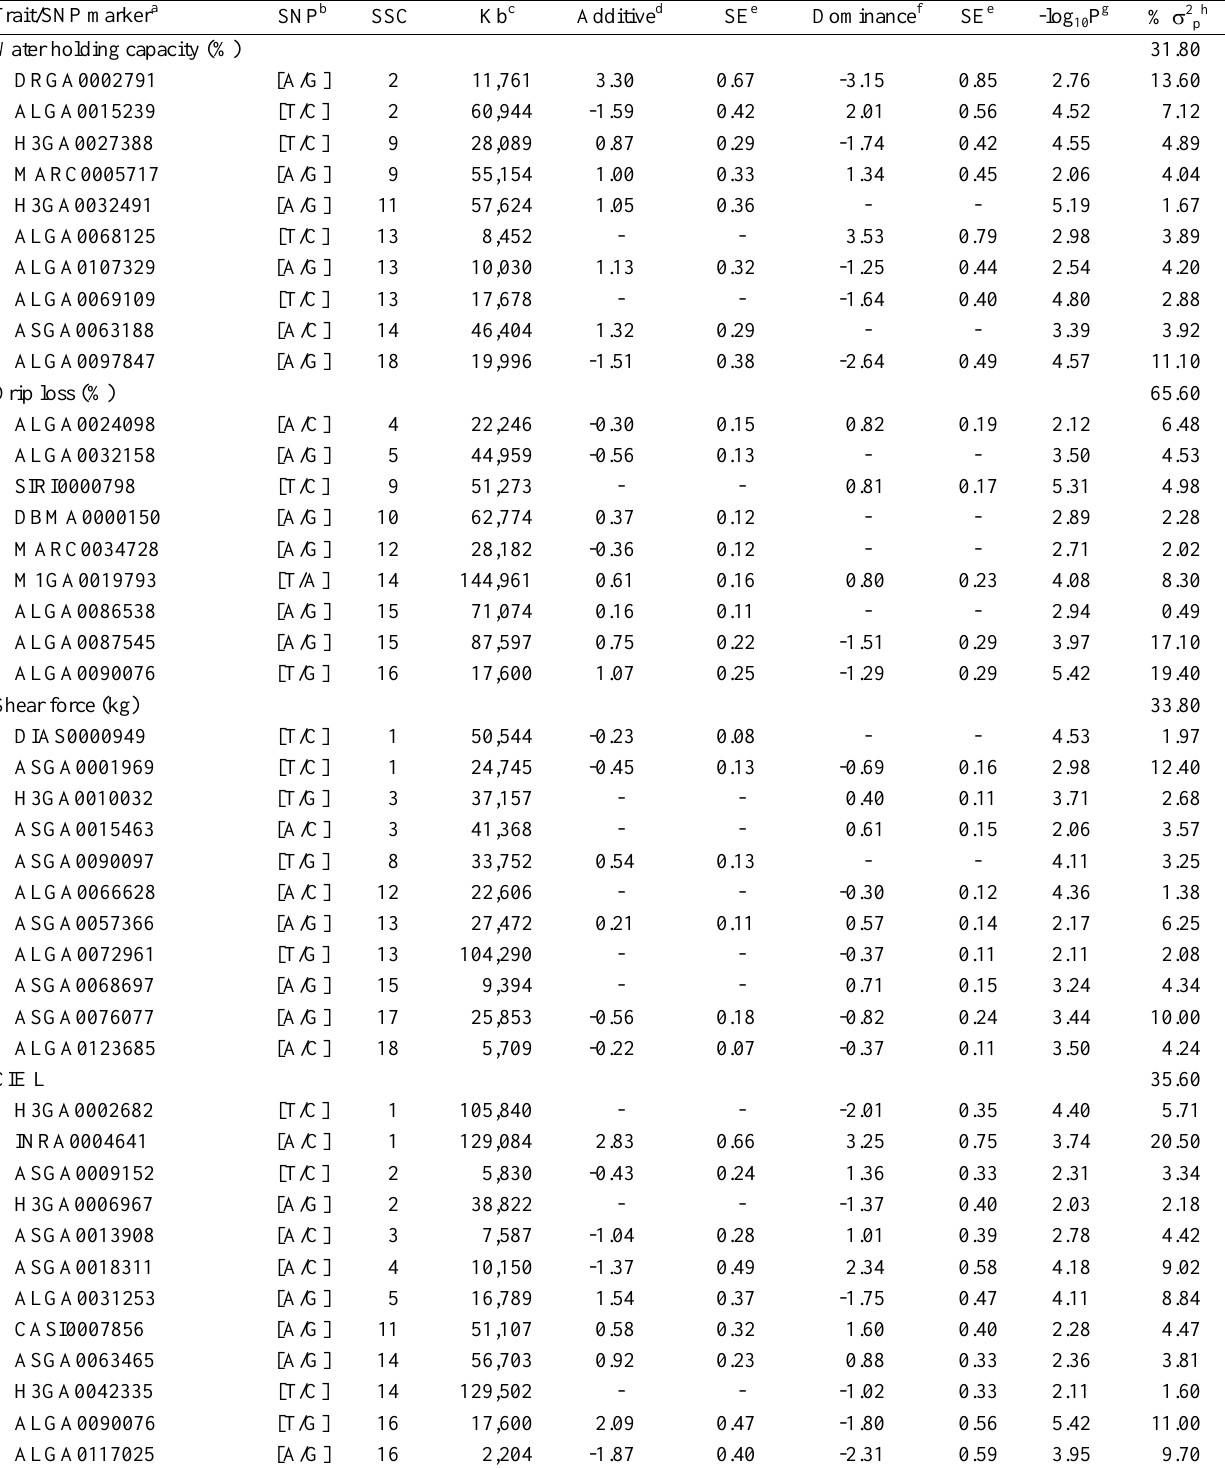
Table 3. Identities, positions of the SNPs with significant effects on meat quality traits in a Korean native pig and Landrace cross population